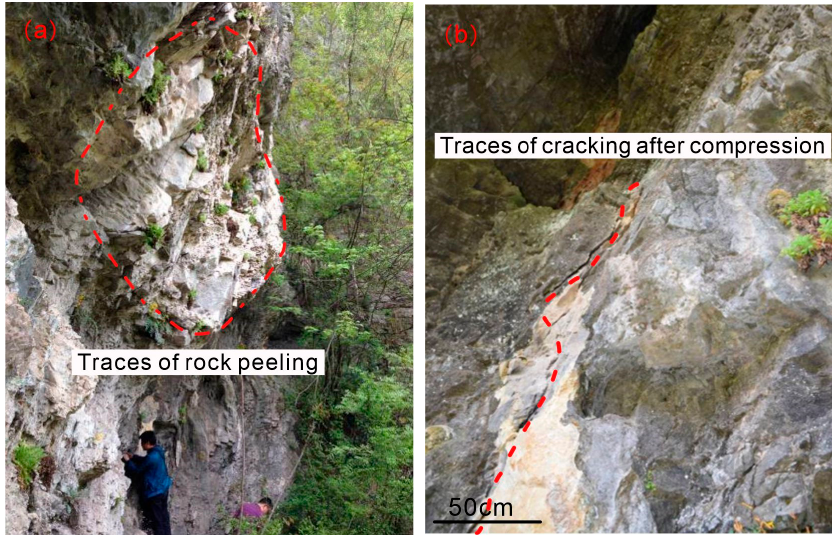
Figure 5. Deformation of the rock base on the east side of the rock mass Yizhuxiang: ( a ) Rock spalling on the base surface on the east side of the collapse body; ( b ) Opening traces of fracturing at the base on the east side of the collapse.